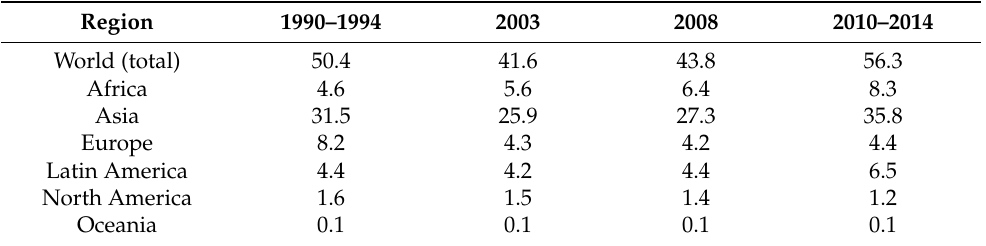
Table 2. Estimated number of induced miscarriages (in millions) in selected years around the world.